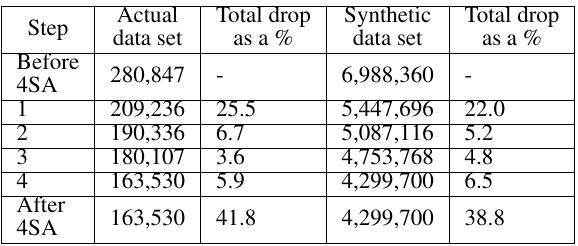
Table 1. Impact of each step on overall reduction of IOI storage